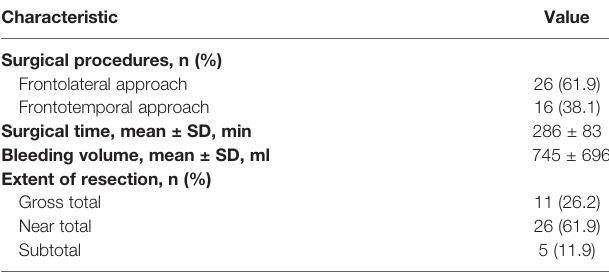
TABLE 3 | Surgery and extent of